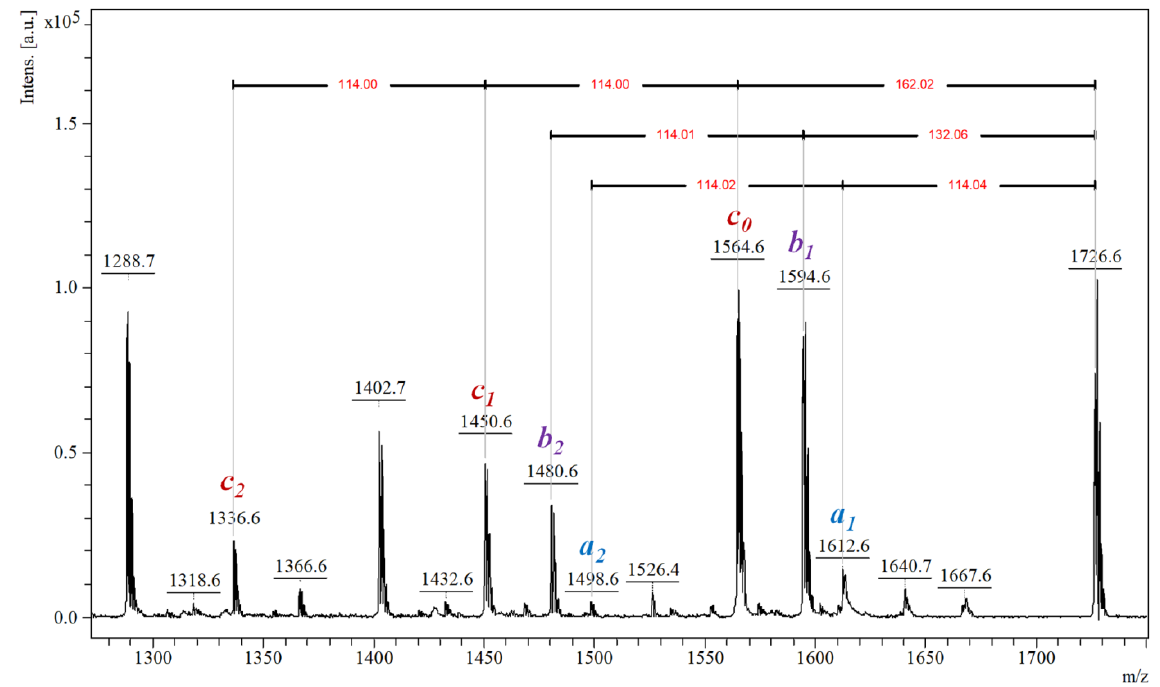
Figure 2. MS/MS fragmentation spectrum of CDCL main product and the observed fragments — series (a, b, and c) .